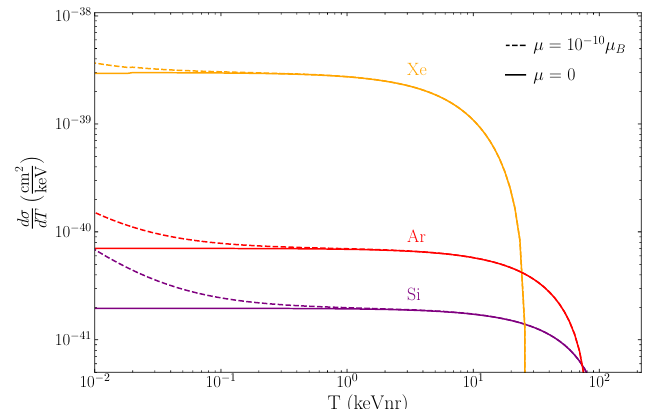
Figure 15 . Di(cid:11)erential cross section for CE (cid:23) NS, as a function of the recoiling energy of the nucleus, in the SM and in presence of a non-vanishing neutrino magnetic moment (cid:22) = 10 (cid:0) 10 (cid:22) B . The di(cid:11)erent colors correspond to di(cid:11)erent target nuclei, as indicated by the labels. The incident neutrino energy is set to E (cid:23) = 40 MeV in all cases, and the cross section in the SM ( (cid:22) = 0) is also shown for